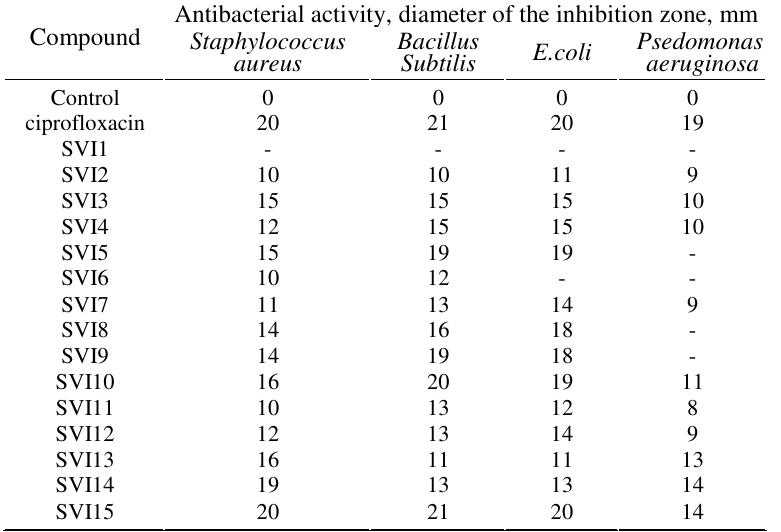
Table 3. Antibacterial activity of phenyl pyrazolo benzothiazolo quinoxaline derivatives. Antibacterial activity, diameter of the inhibition zone, mm Compound Staphylococcus Bacillus aureus